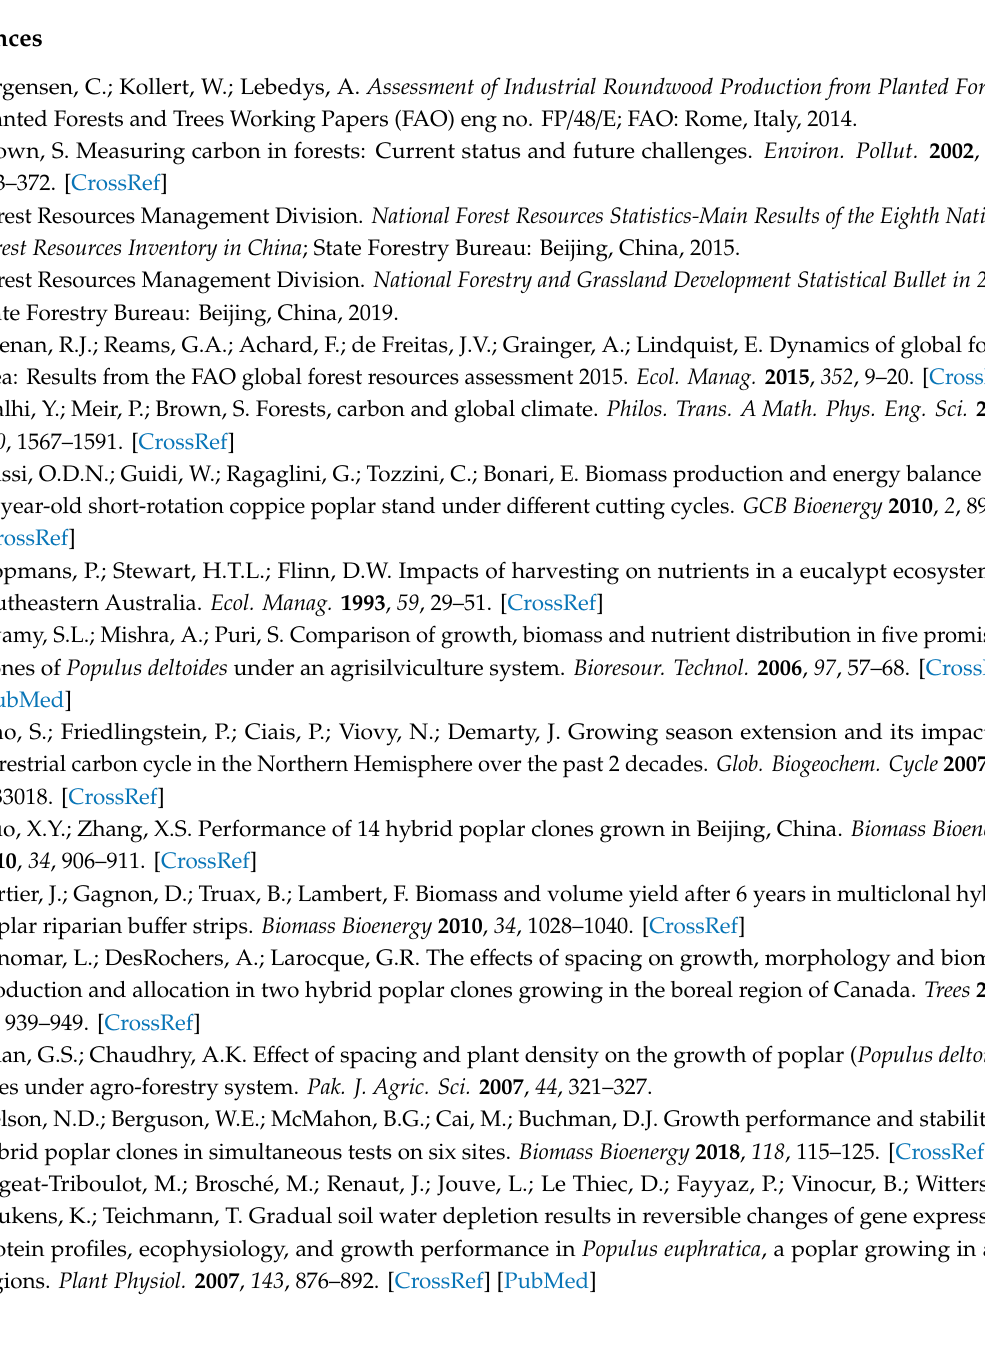
Table S1: Parameters of poplar DBH , H , and tree volume models with di ff erent treatments; Table S2: Comparison of models and measured data of poplar tree volume for smoothed data set, X 1 , X 2, and X 3